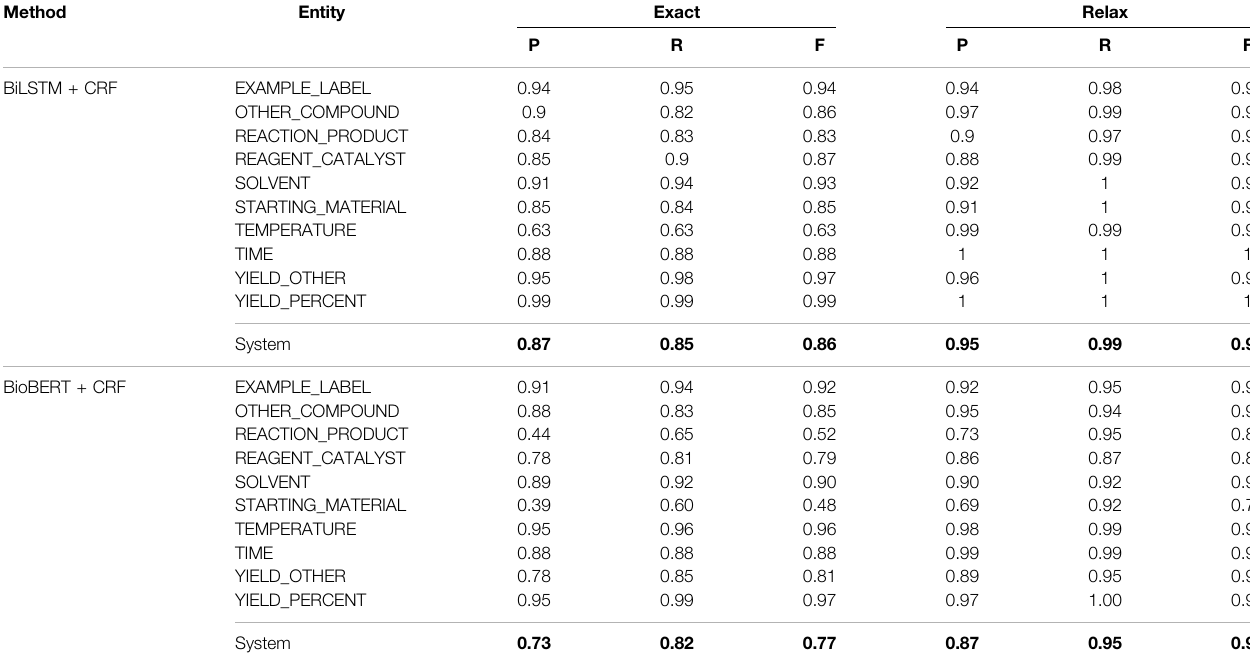
Bold indicates system performance of both